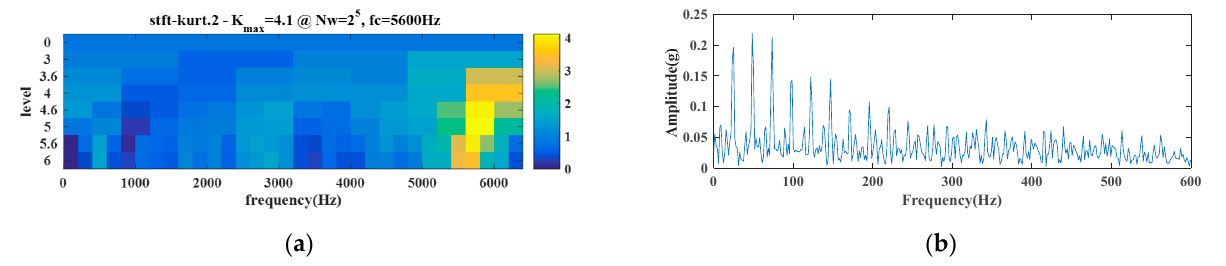
Figure 22. SK analysis results of experimental compound fault signal: ( a ) kurtogram; ( b ) envelope spectrum of the filtered signal.